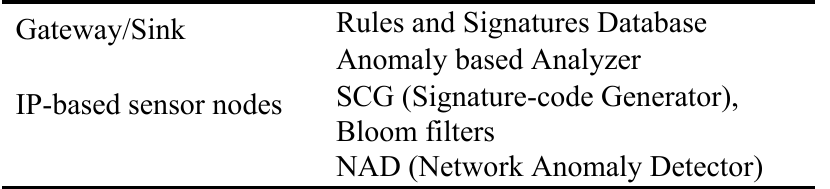
Table 1. Main Components of RIDES and Their Placement.